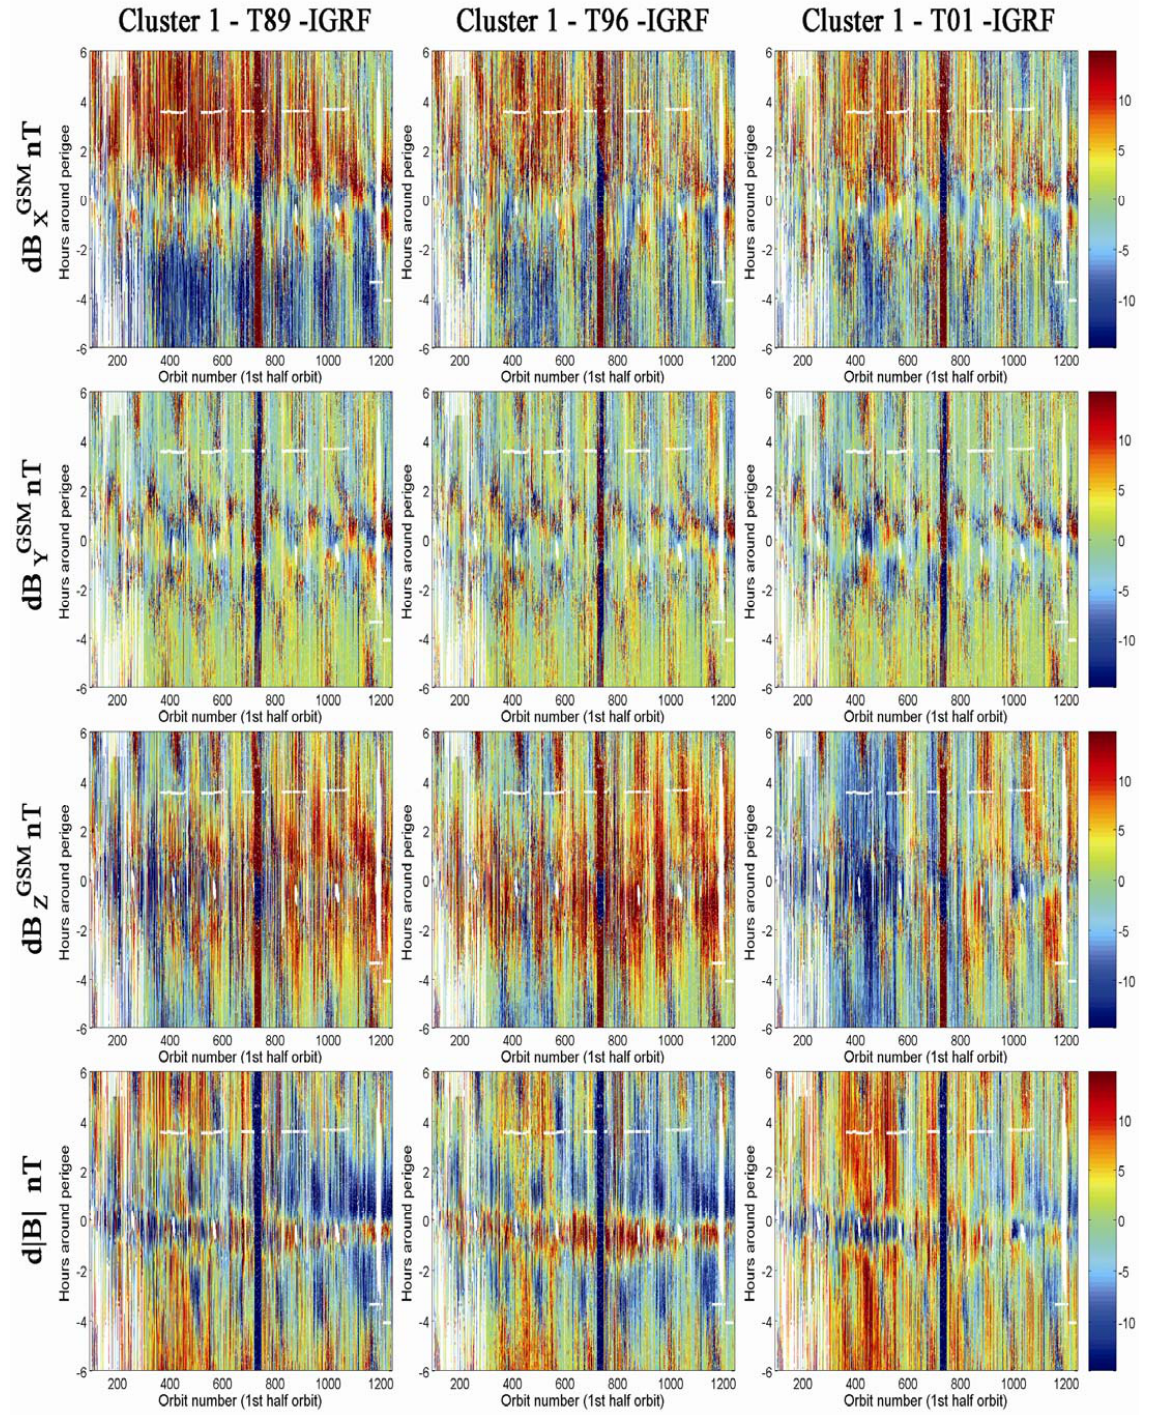
Fig. 5. Plots of the residuals from the comparisons of Cluster S/C 1 observations with T89, T96 and T01 models for the whole eight years data. Each vertical strip is a section of an orbit – the x-axis is the orbit number, y-axis is time relative to perigee and the colour scale is the value of dB XGSM , dB YGSM , dB ZGSM (each row), the panels from the left to right columns are the residuals from T89, T96 and T01,